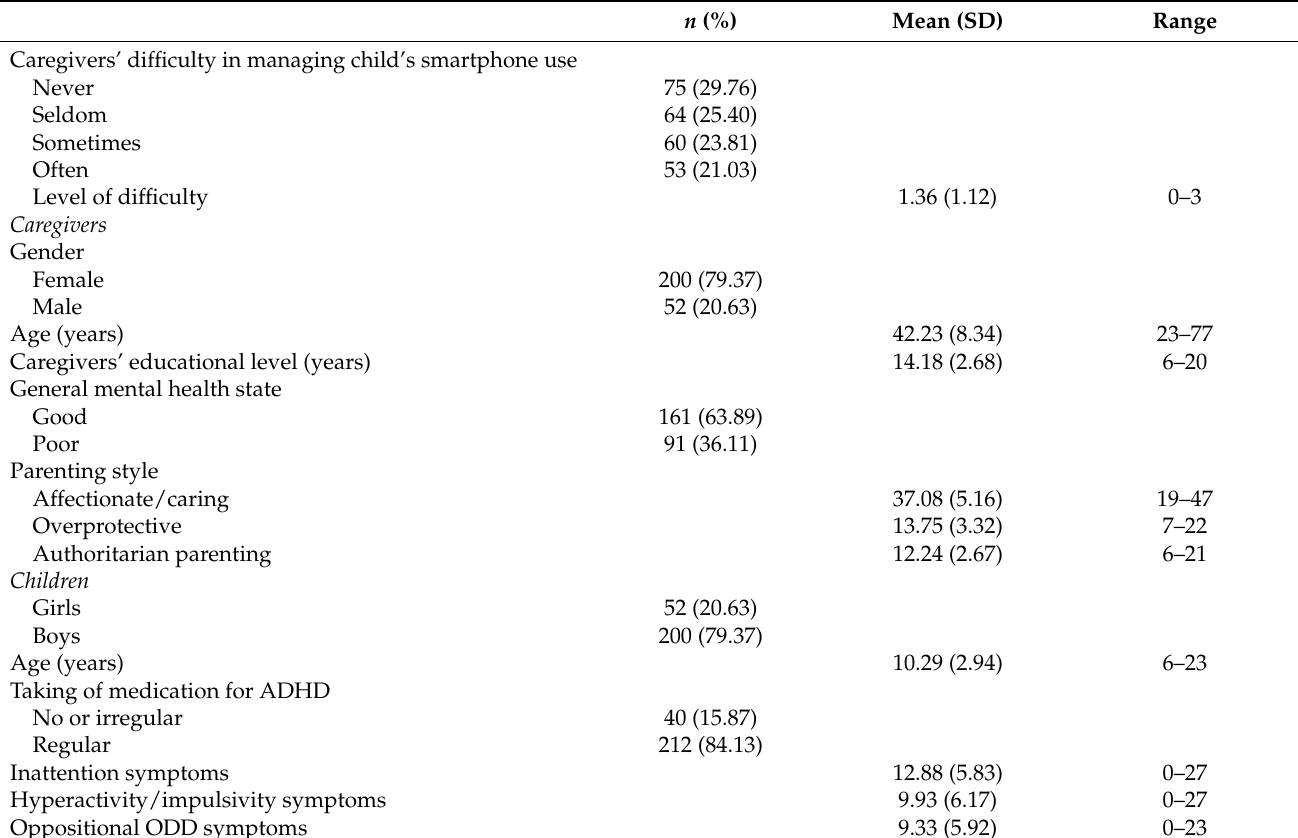
Table 1. Caregivers’ Difficulty in Managing Smartphone Use of Children and Caregiver- and Children- Related Factors ( n =